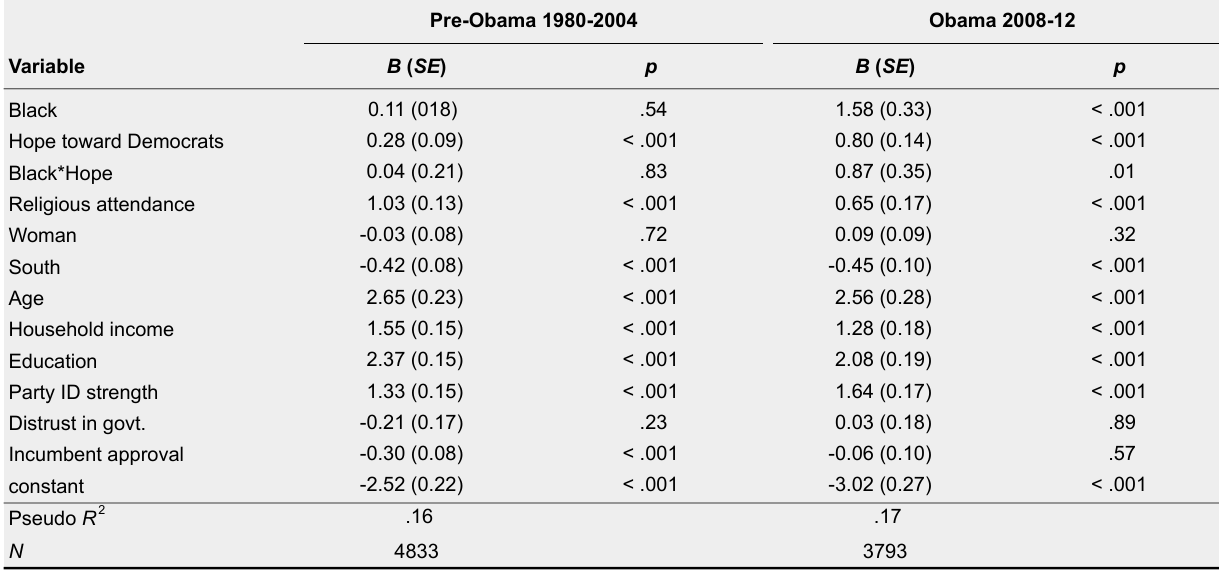
Logit Models Interacting Race and Hope Toward Favored Partisans on Democrats’ Vote Likelihood, Across Pre-Obama and Obama